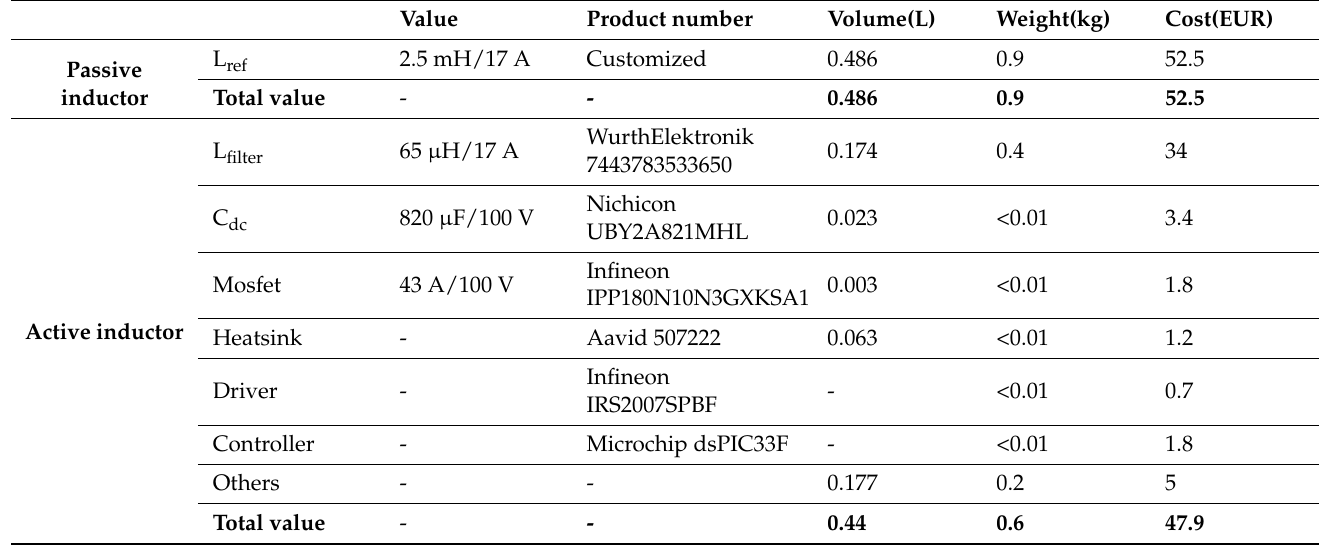
Table 2. Reliability-oriented component sizing